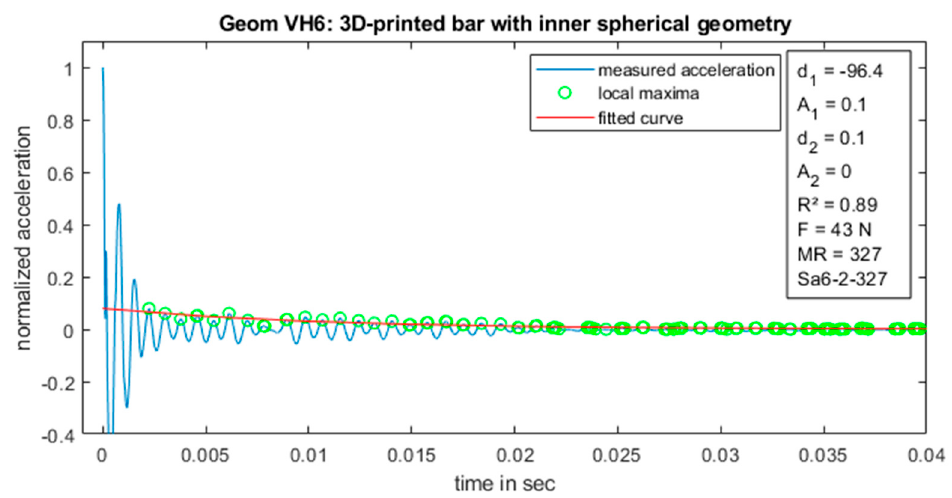
Figure 10. Acceleration data and fitted curve for a 3D-printed bar with inner spherical geometry.